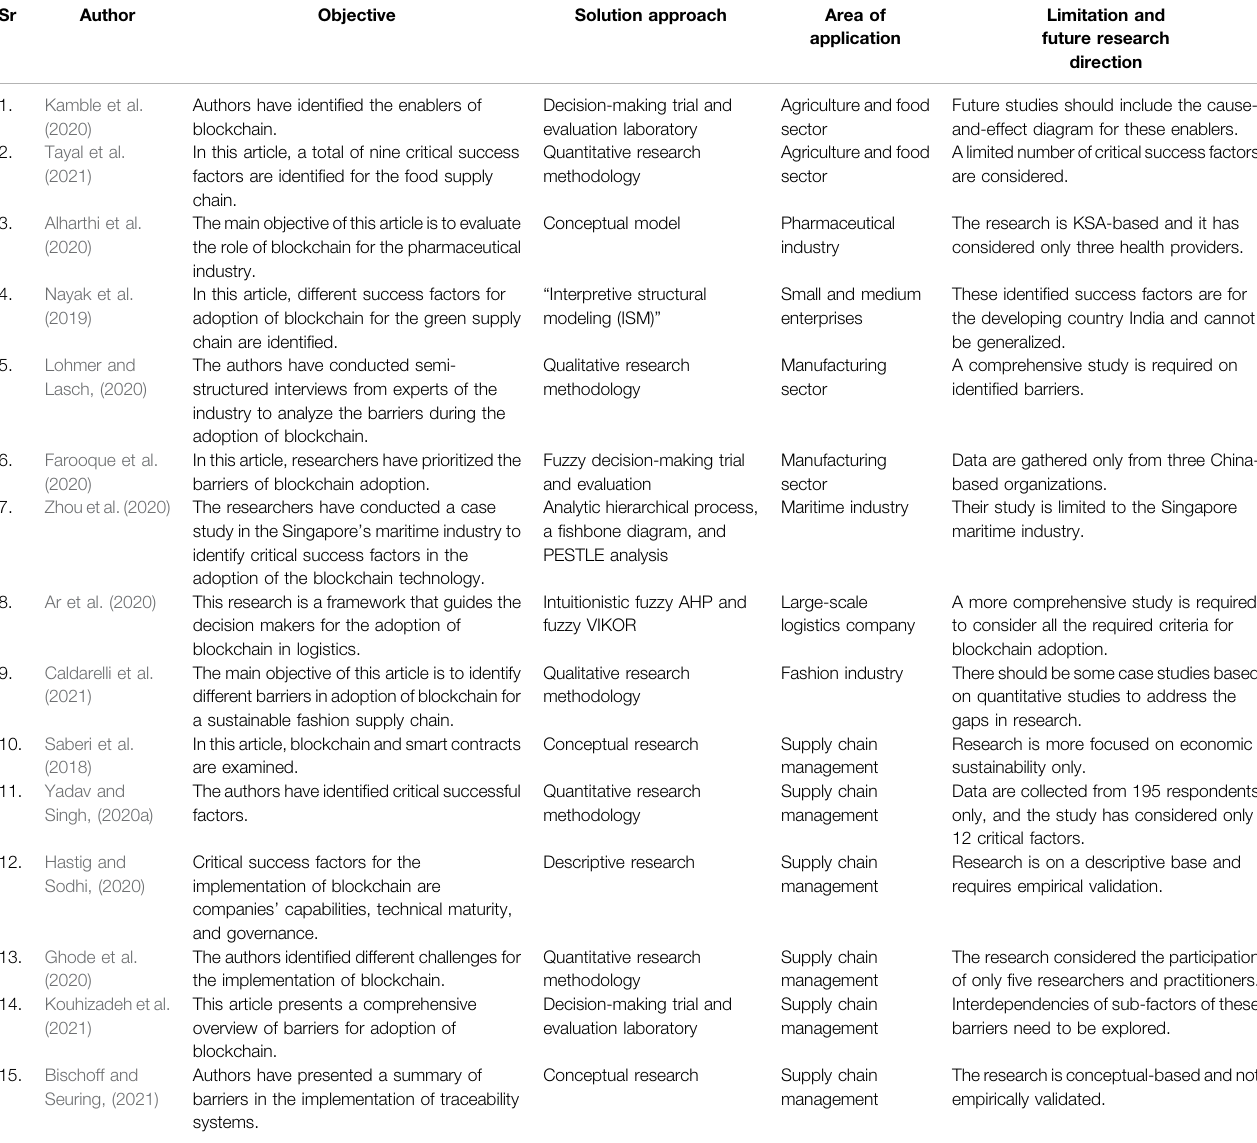
TABLE 5 | Article list about different challenges in adoption of blockchain for an economically sustainable supply